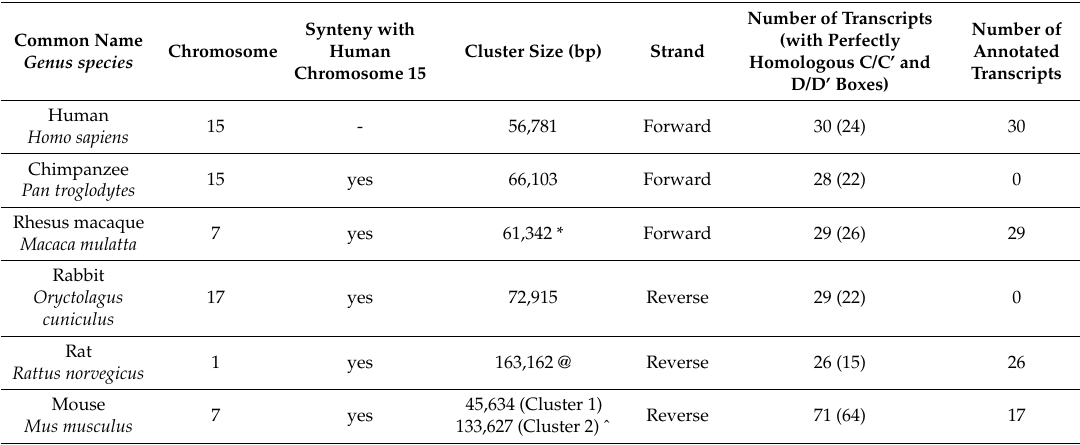
Table 1. SNORD116 snoRNA clusters in different